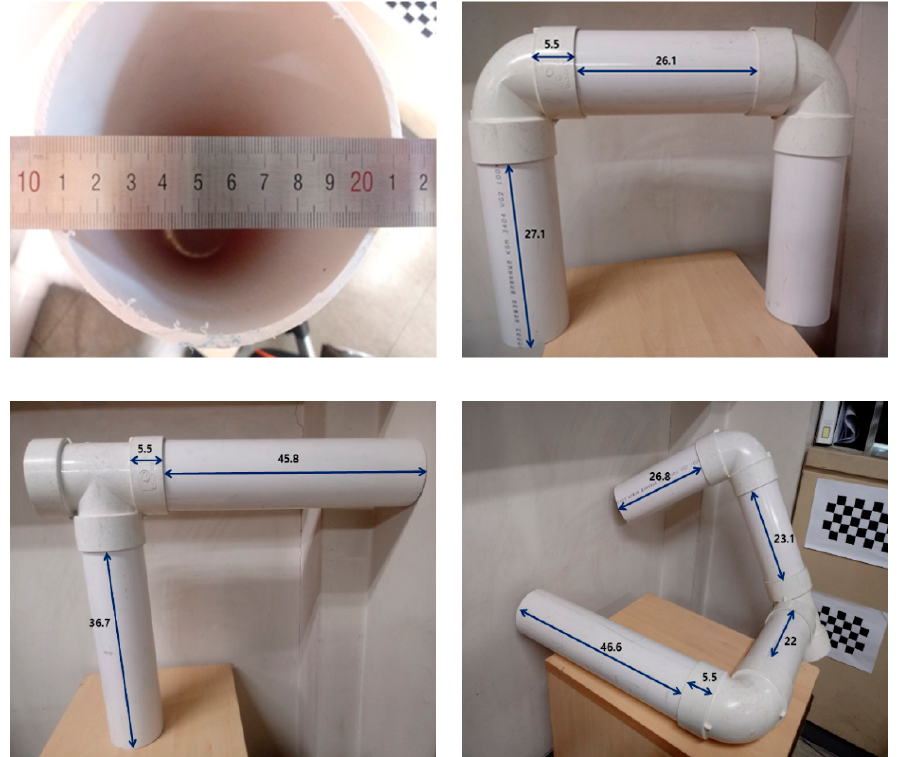
Figure 21. Three types of pipeline with 100 mm polyvinyl chloride (PVC) (cm).